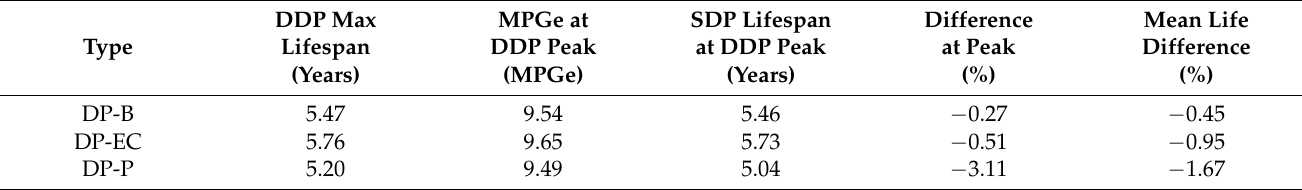
Table 4. Comparison of DP Controllers for N pc =